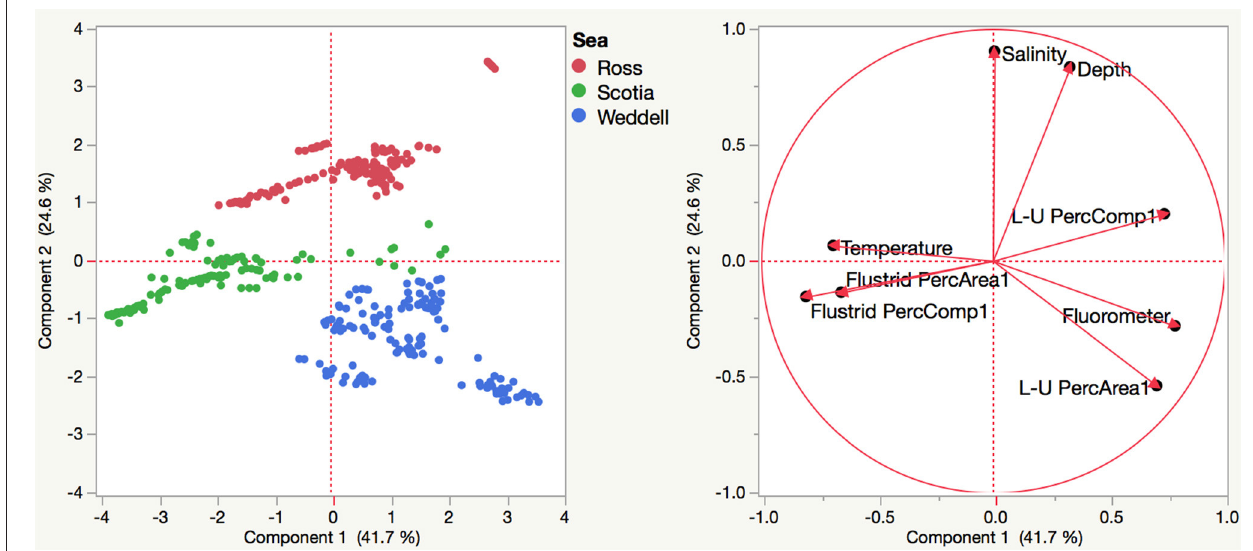
FIGURE 5 | Principle components analysis based on the percent areas and percent compositions of bryozoans along with environmental variables collected at each site among the three Antarctic regions. L-U, Lepralio-Umbonulomorph bryozoans.